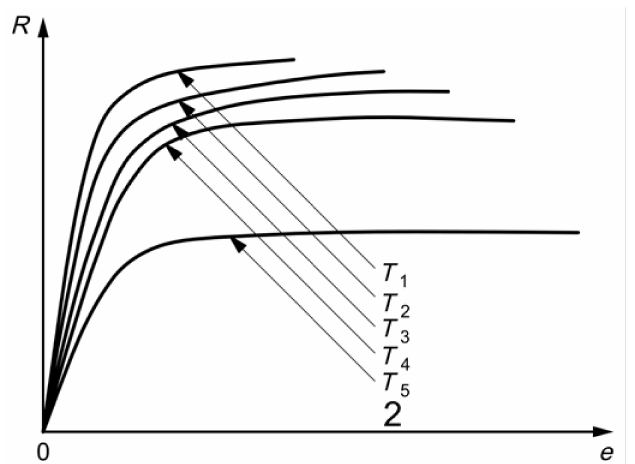
Figure 1. Stress-strain curves at a given strain rate and different temperatures ( R : stress/MPa;